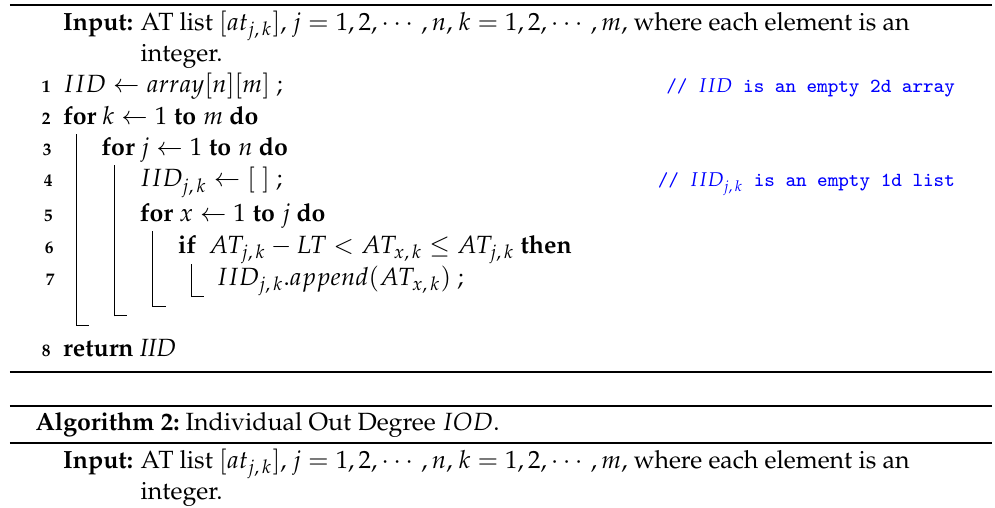
Algorithm 1: Individual In Degree IID .